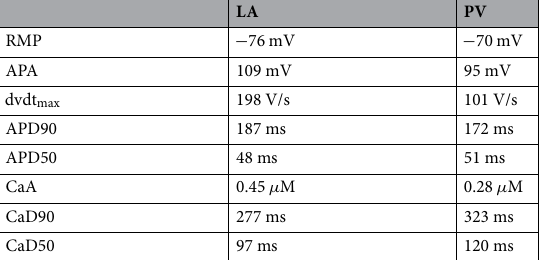
Table 4. Biomarker values for the LA and PV versions of our base model at 1 Hz pacing. Selected biomarkers include the resting membrane potential (RMP), the action potential amplitude (APA), the maximal upstroke velocity of the action potential ( dvdt max ), the action potential durations at 90% and 50% repolarization 2 + 2 + (APD50 and APD90), the amplitude of the cytosolic Ca transient (CaA), and the cytosolic Ca transient durations at 90 and 50% (CaD50 and CaD90). These biomarkers are defined in the “Defining biomarkers” section.